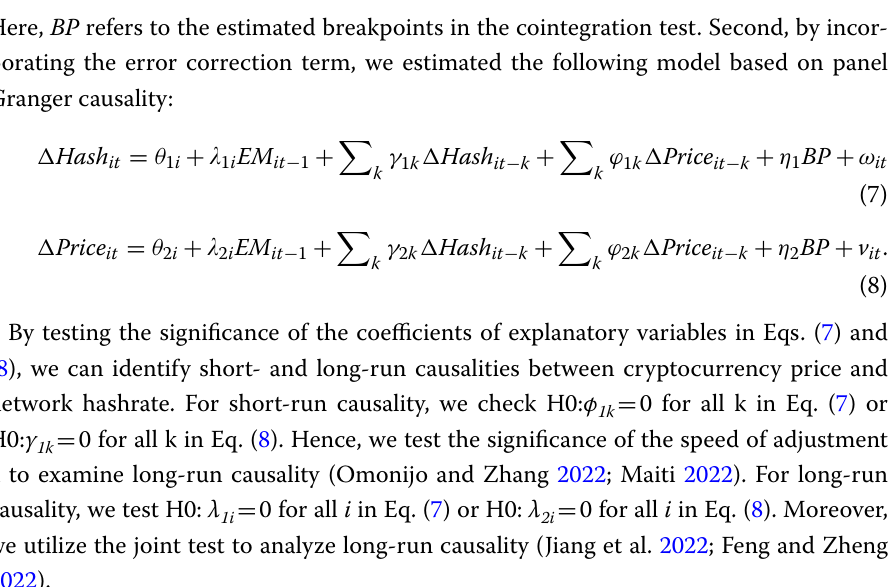
Vector error correction model